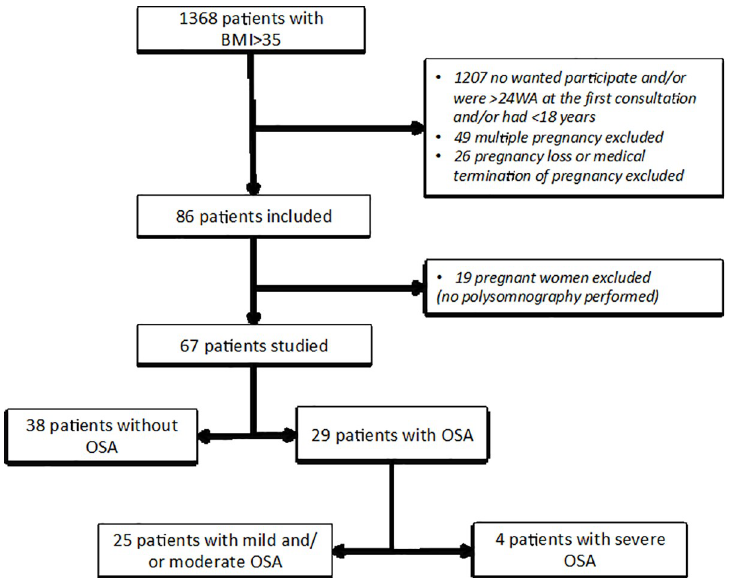
Fig 1. Flow chart. BMI = Body Mass Index; OSA = obstructive sleep apnea.